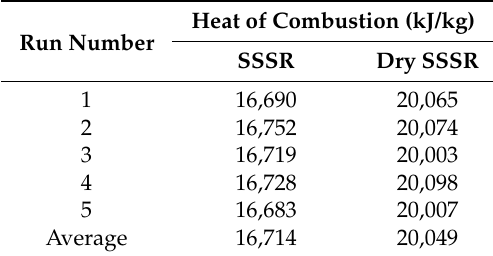
Table 6. Heats of combustion of SSSR.